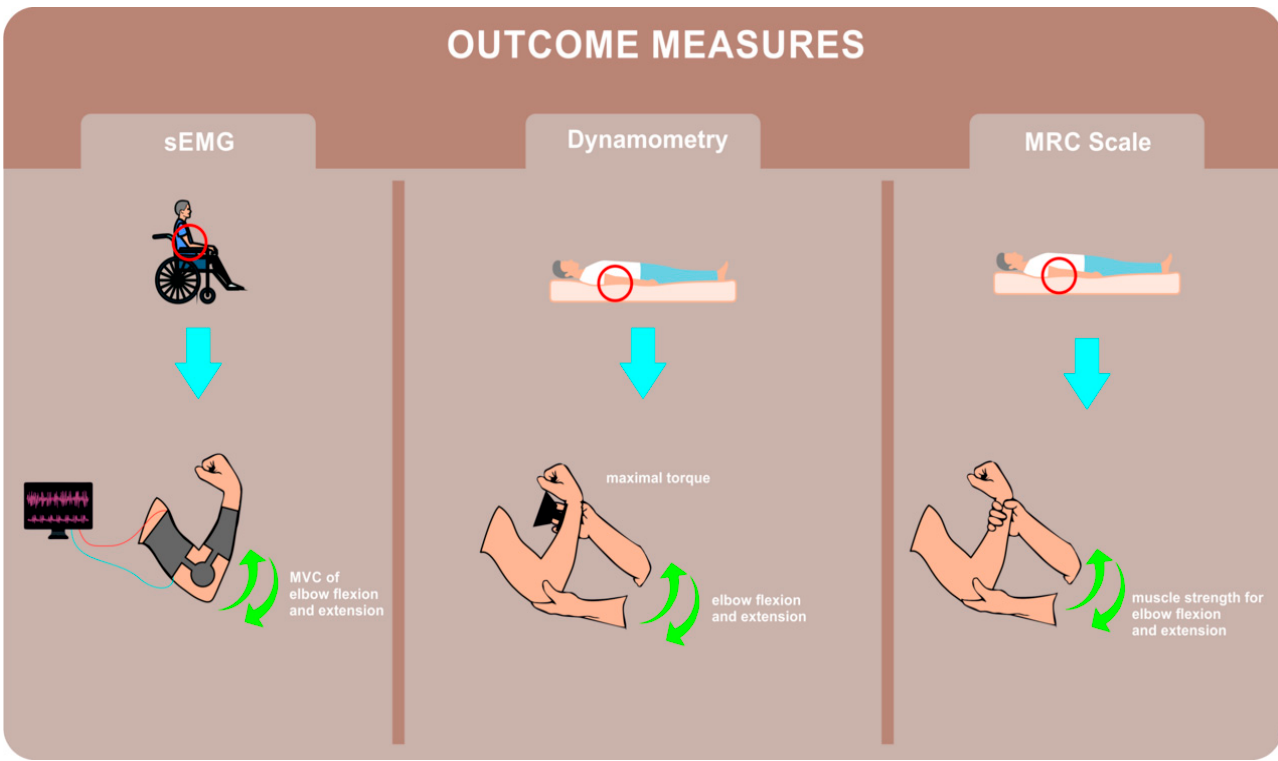
Figure 1. Visualization of the outcome measures applied. sEMG = surface electromyography. MVC = maximal voluntary contraction. MRC Scale = Medical Research Council Scale.